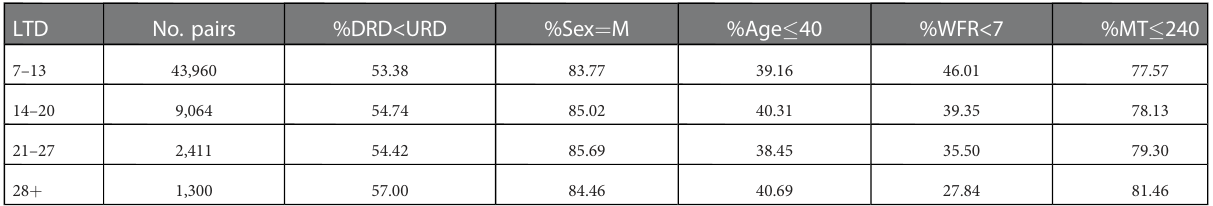
TABLE 2 Number of race-pairs for different max disruption lengths (N) broken down for sex, age, timing and ability. Here WFR denotes weeks-from- race-day, DRD refers to disrupted race date and UDR refers to undisrupted race date. LTD No. pairs %DRD<URD %Sex ¼ M %Age (cid:2)